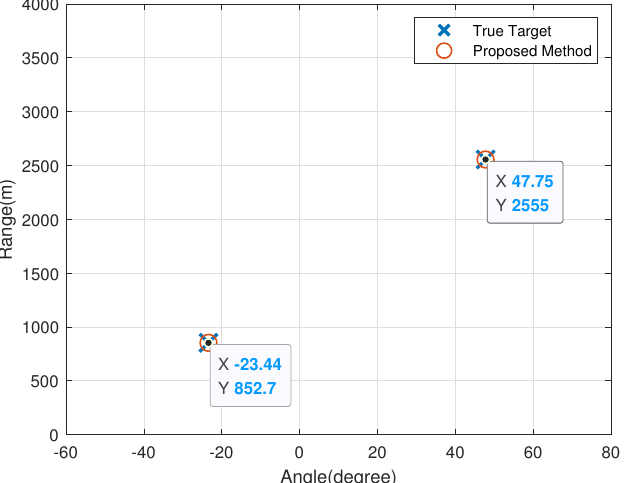
Figure 2. Two-dimensional point cloud image of estimated